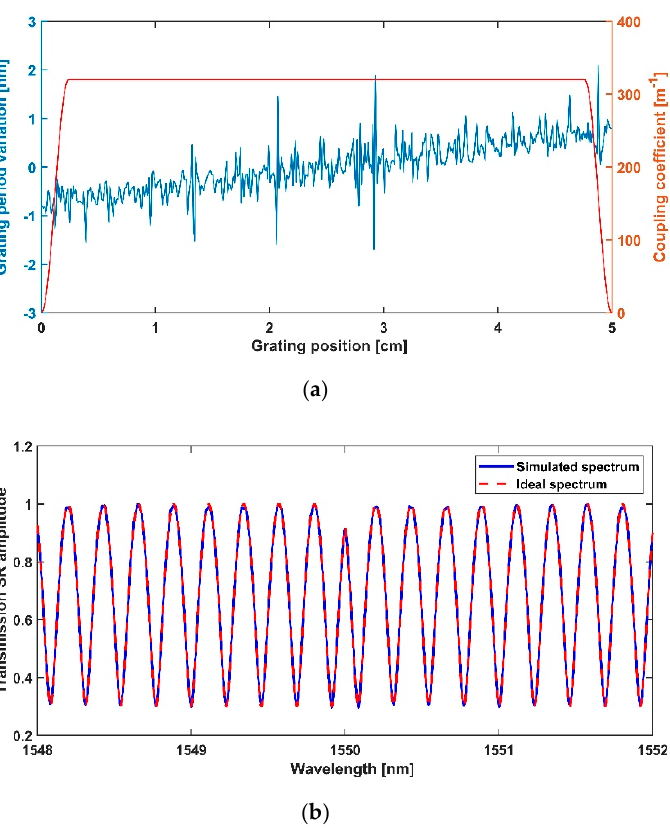
Figure 2. ( a ) Grating period (blue line) and coupling coefficient (red line) of the designed 0.5th-order photonic Hilbert transformer (PHT) and ( b ) comparison between ideal spectrum (dashed red line) and simulated spectrum (blue